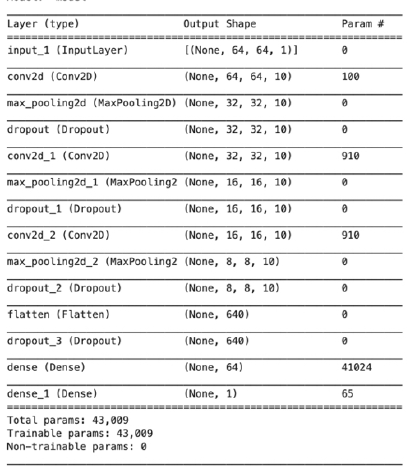
Figure 4: Performance of compact layered